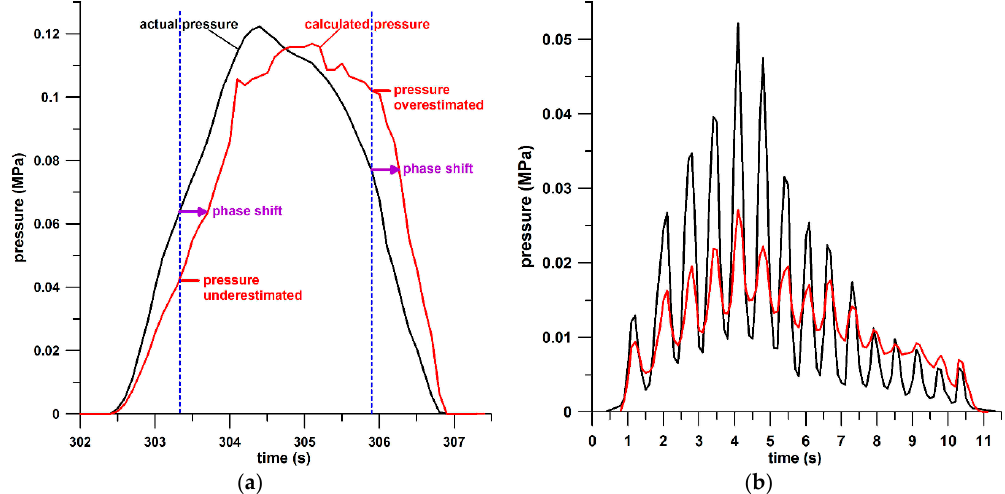
Figure 8. Pressure obtained from the force plate data (black) and from the sensor (red; calculated from the calibration curve) against time. ( a ) The inaccuracies resulting from using peak data for calibration can be seen as inaccuracies of magnitude (under- and overestimation of the pressure data) at the correct time, or as time inaccuracies of accurate pressure affected by a phase shift (slight delay); the indicated phase shift (purple arrow) corresponds to approximately 0.4 s. ( b ) Fast pressure changes (approx. 1.5 Hz loading cycles) exhibit the damping effect (reduced peak data) caused by the sensor structure (viscous structure of sensor plus